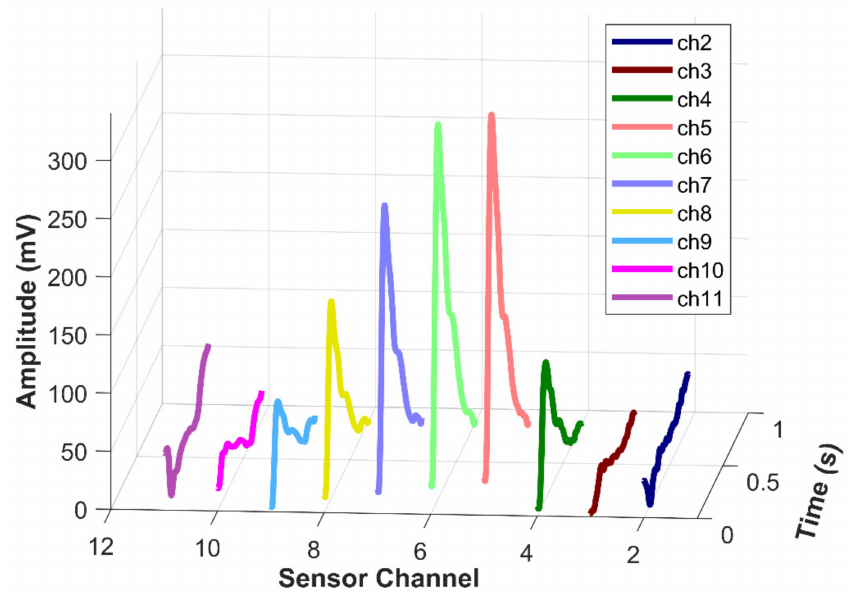
Figure 6. Selected channels of the pulse signal from a subject.